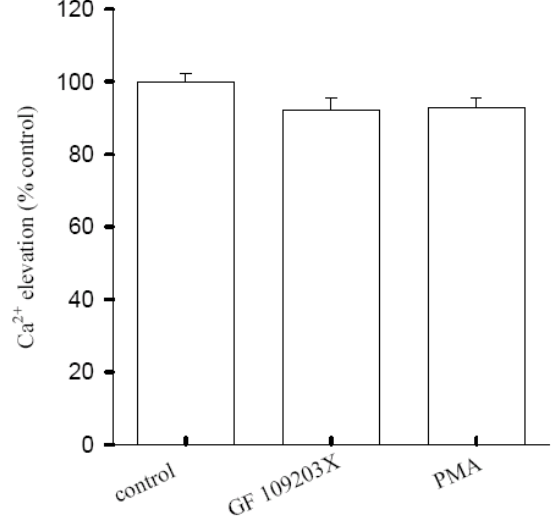
Figure 5. Effect of protein kinase C modulator on [10]-gingerol-induced [Ca 2+ ] Experiments were performed in Ca 2+ -containing medium. PMA(10 nM) or GF 109203X (2 μ M) was added 1 min prior to 25 μ M 10-gingerol. Data are expressed as the percentage of control that is the net area under the curve of 25 μ M-[10]-gingerol-induced [Ca 2+ ]i rise (30-250 sec interval), and are means ± SEM of five experiments.